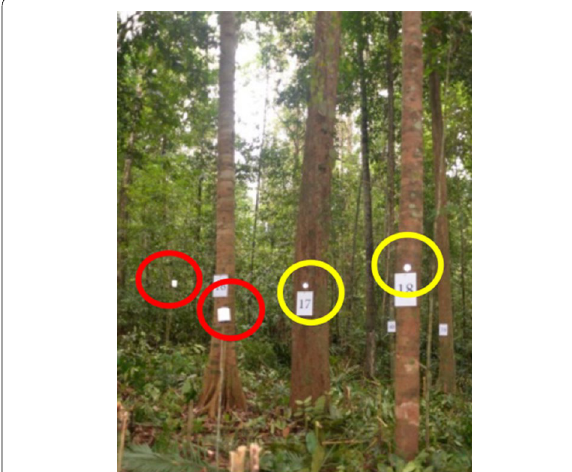
Fig. 3 Setting of circular (yellow color) and cylindrical (red color) reflectors in sample plots